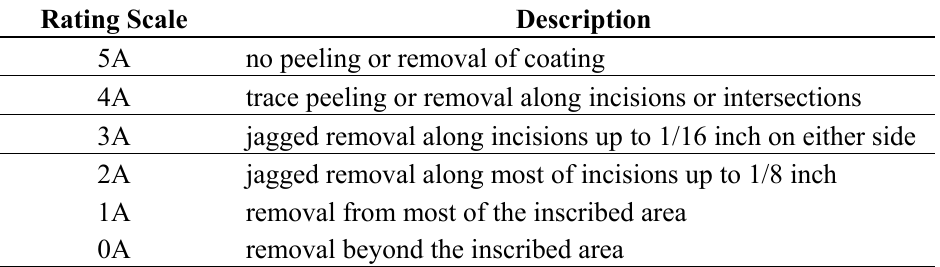
Table 3. ASTM D 3359 Adhesion, Method A, rating scale with